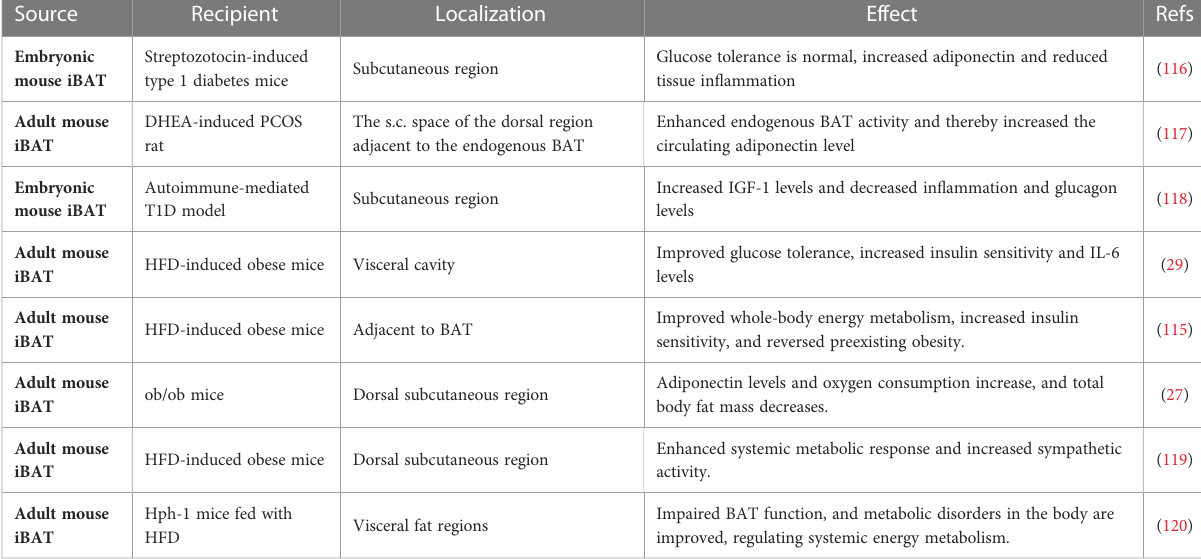
TABLE 3 The effects of experimental BAT